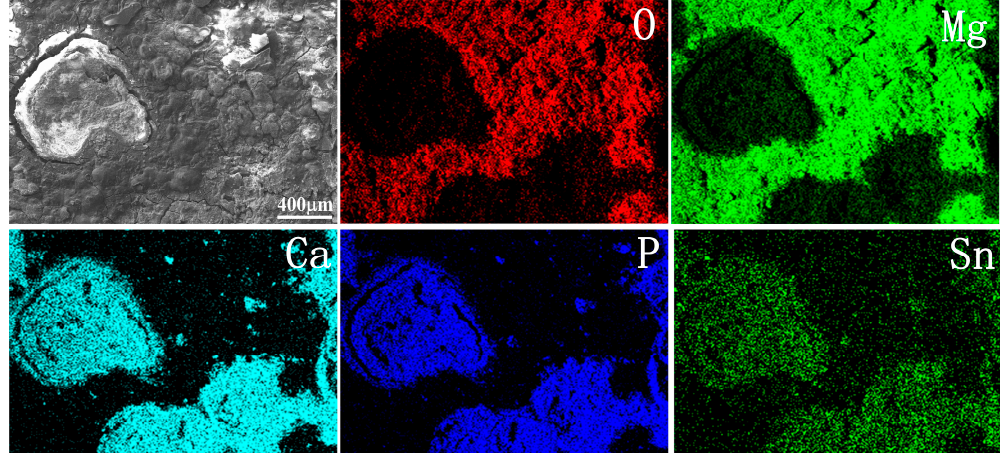
Figure 10. EDS spectra of hot-rolled Mg − 5Sn − 1Zn − 0.5Ca alloy after immersion in Hank’s solution for 7 days.